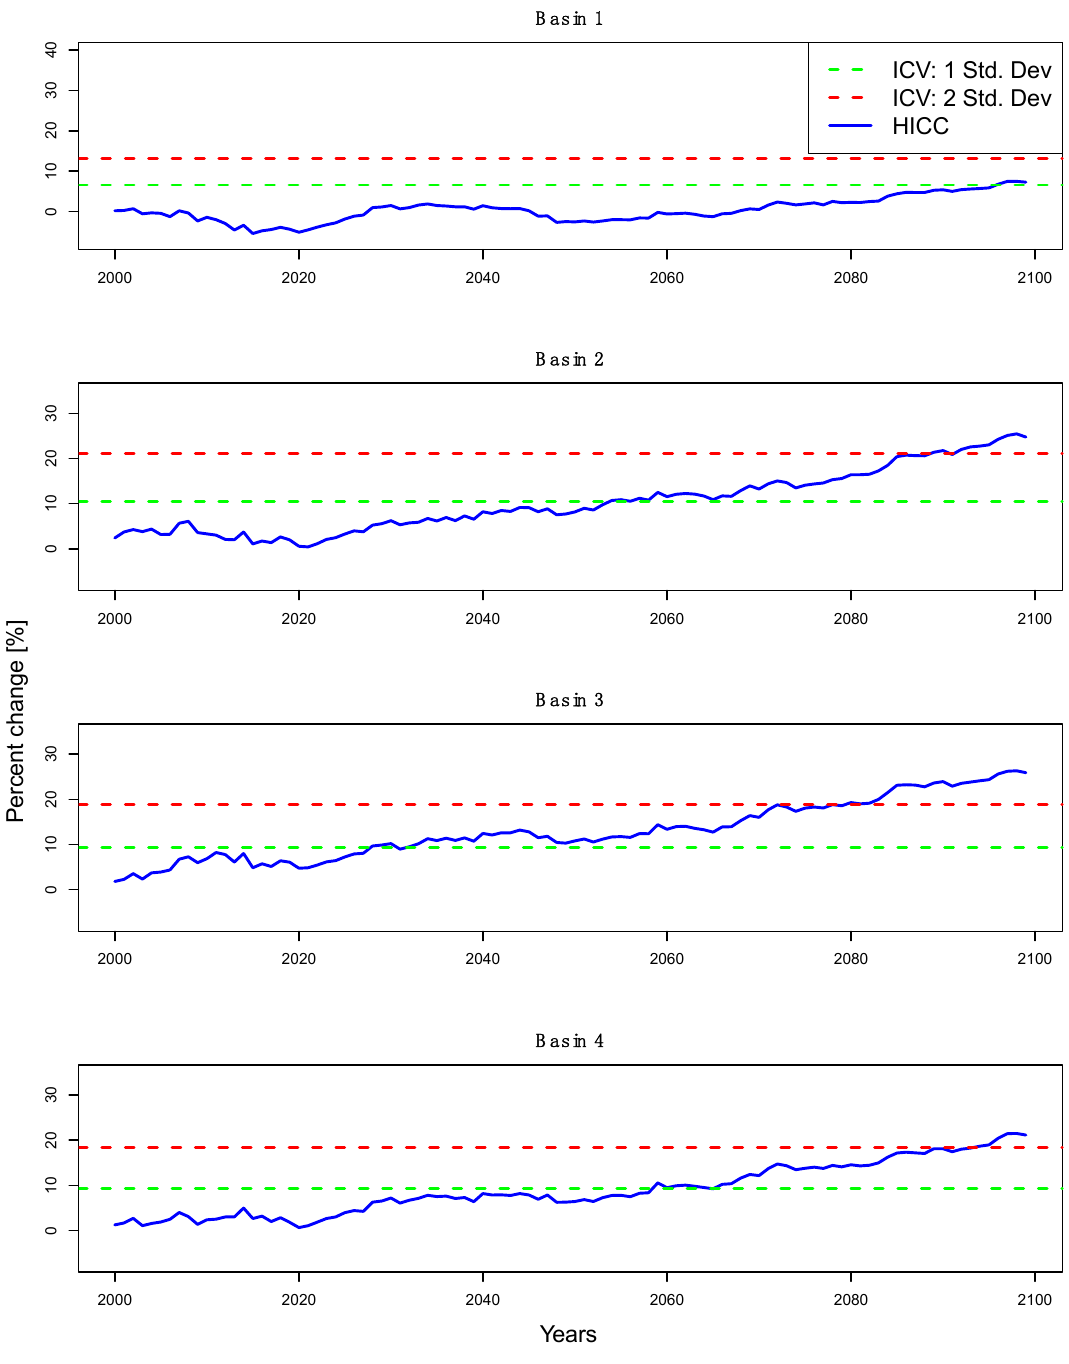
Figure 6. Time of emergence for mean annual streamflow conditions for watersheds (1–4).